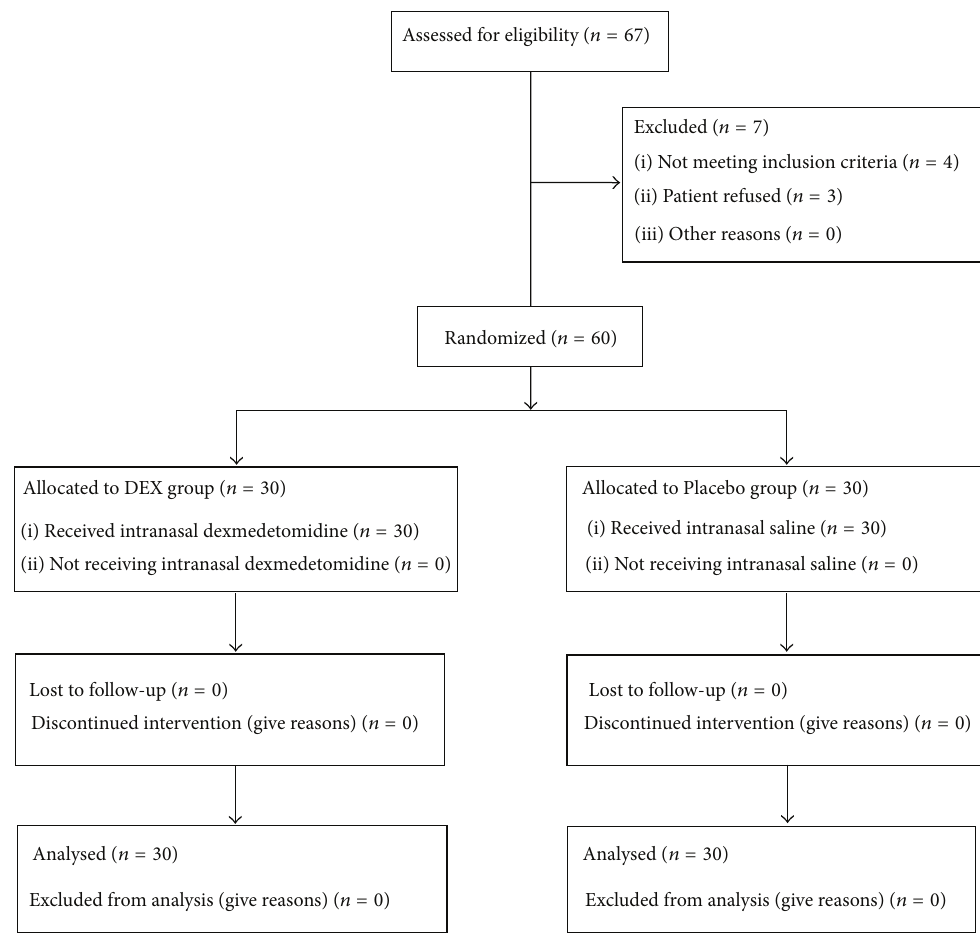
Figure 1: Flow diagram of patient